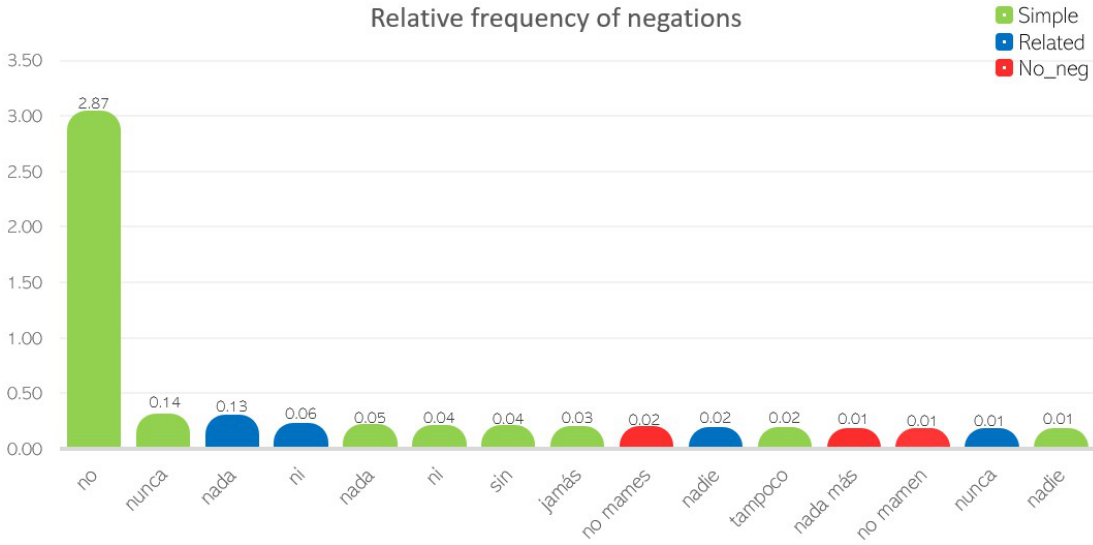
Figure 3. Histogram of negations in the corpus. Green stands for neg_ex, blue refers to neg_rel tag, and red means